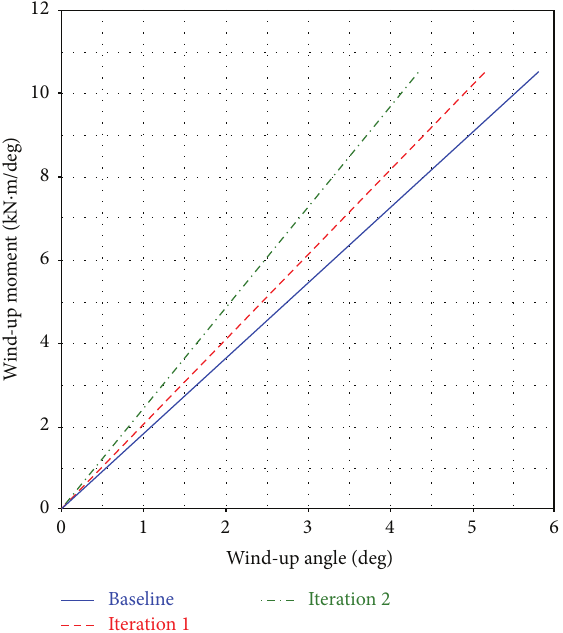
Figure 7: Comparison of wind-up moment versus wind-up angle curve.